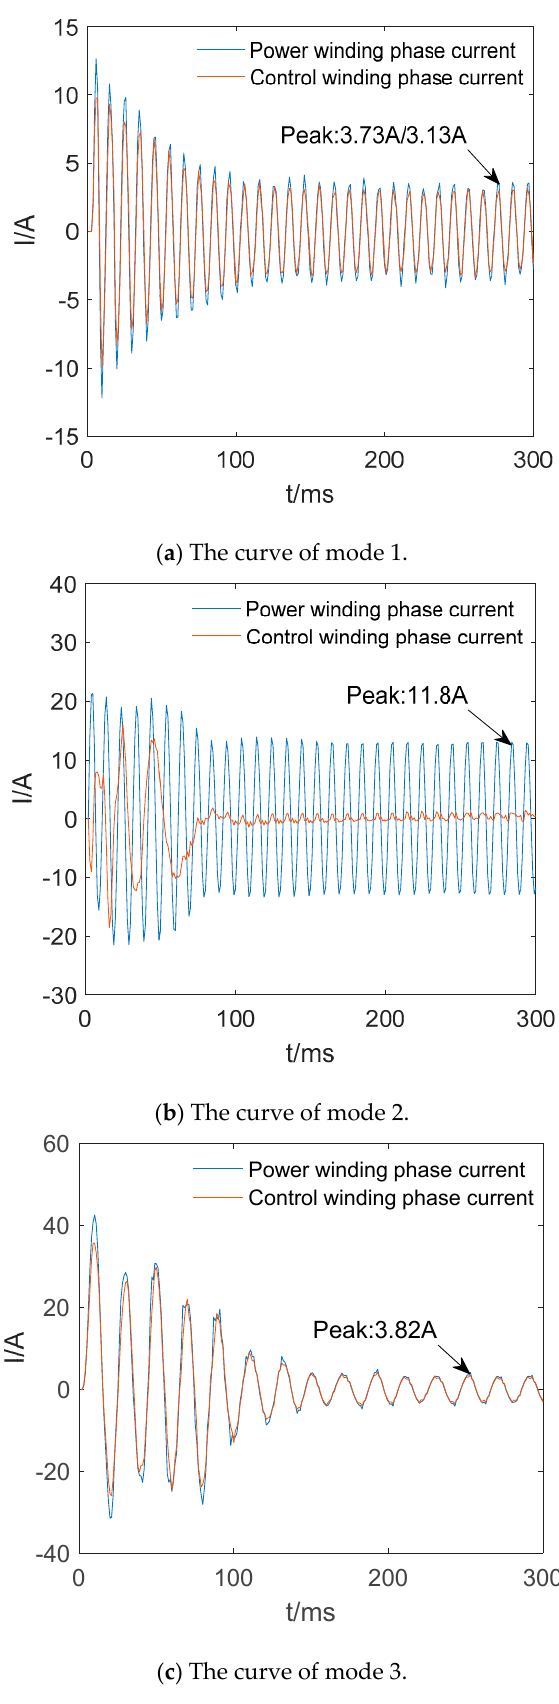
Figure 14. The phase current of the stator winding under no